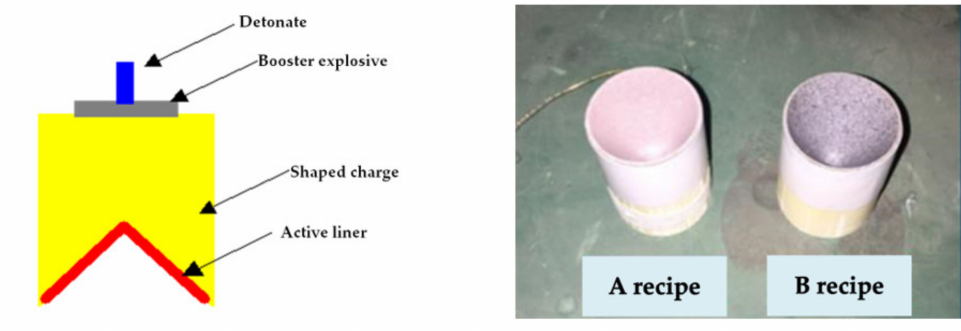
Figure 3. X-ray pulse test arrangement.